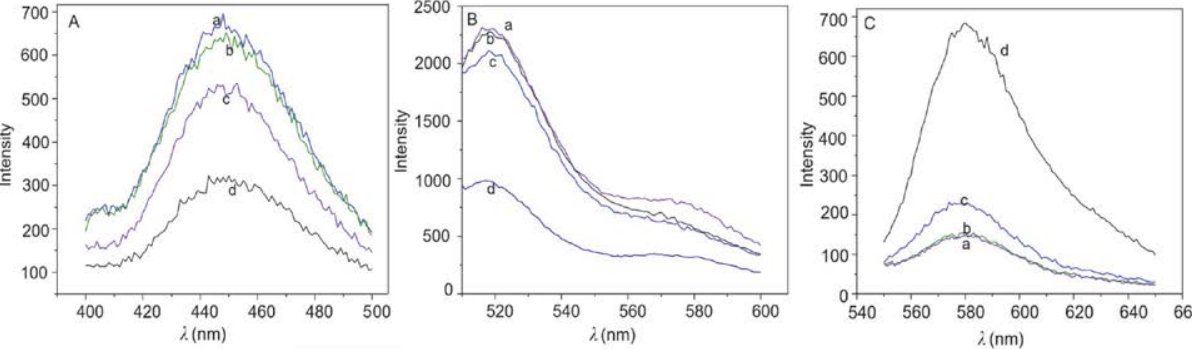
Figure 7. Fluorescence curves of (A) Pb 2+ (with added standard concentration of (a) 0, (b) 50 nM, (c) 300 nM, and (d) 700 nM), (B) Ag + (with add- ed standard concentration of (a) 0, (b) 10 nM (c) 100 nM, and (d) 700 nM), and (C) Hg 2+ (with added standard concentration of (a) 0, (b) 10 nM (c) 100 nM, and (d) 700 nM) in East Lake water. Table 2. Standard Recovery Test for detection of the metal ions in East Lake water. Measured concentration Measured concentration Added standard